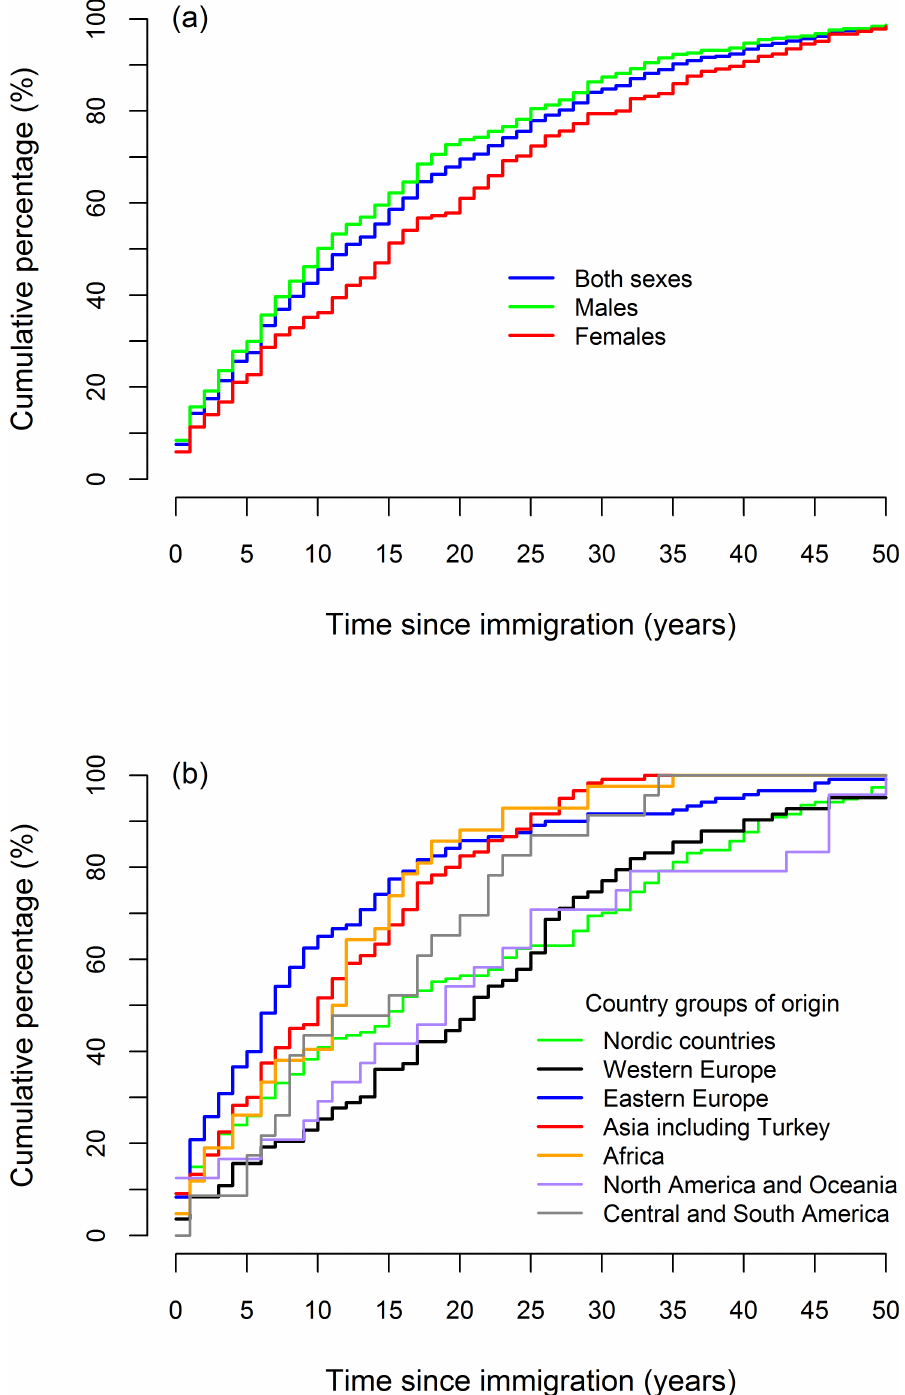
Fig 3. Cumulative percentage distribution of suicides of first-generation immigrants by sex (a) and country group of origin (b) according to time since immigration a . a Time since immigration refers to the time span between the date of immigration to Norway and the date of suicide